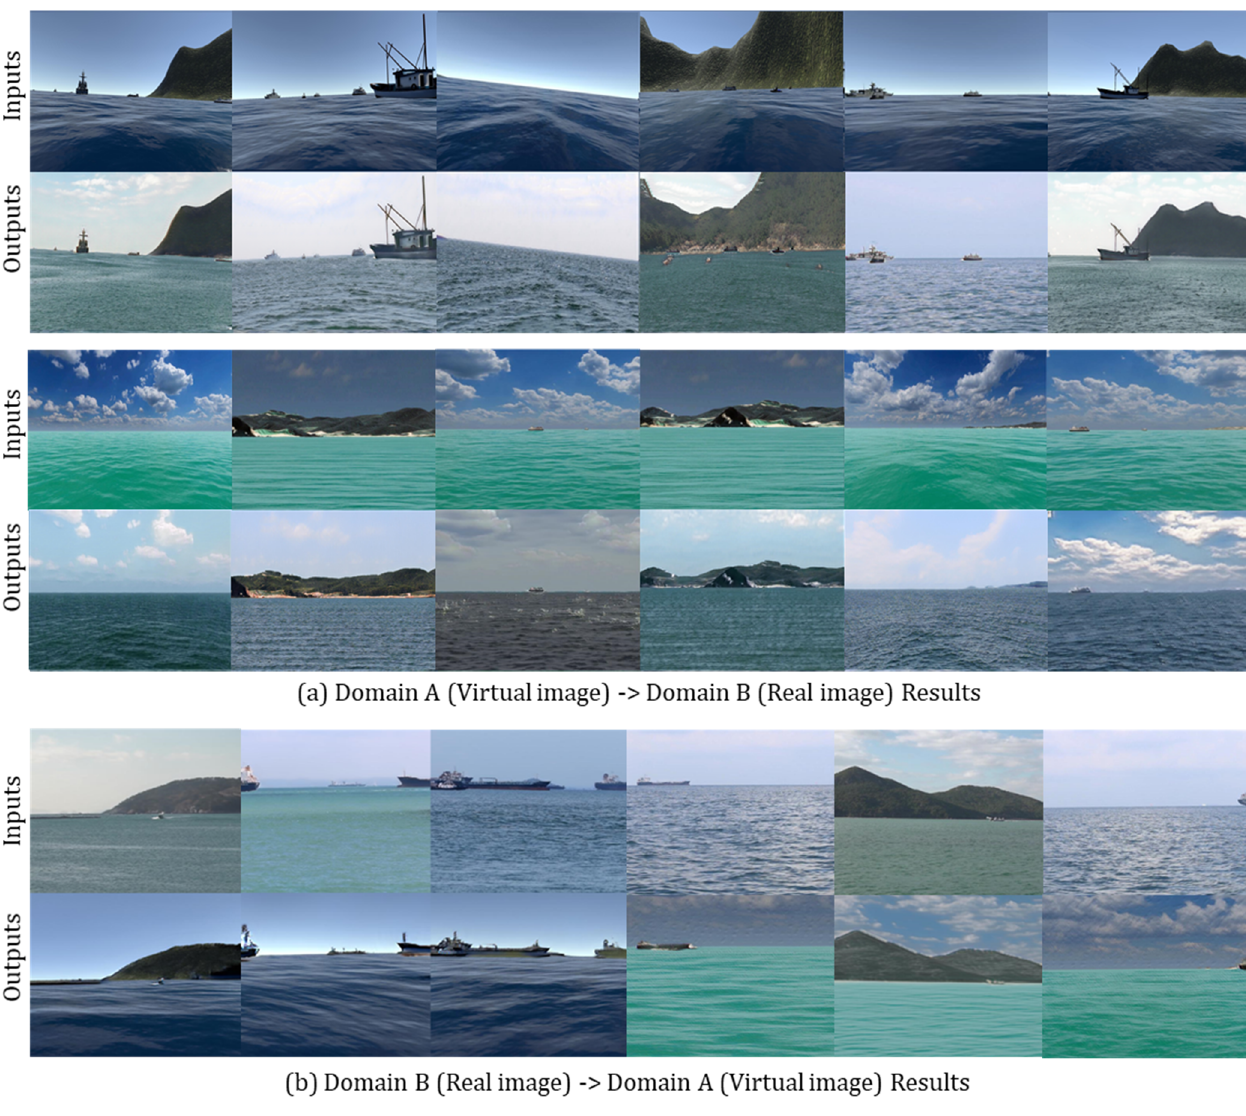
Figure 7. Results of the proposed generator: ( a ) results of image translation from the virtual to real domain, and ( b ) results of image translation from the real to virtual domain.